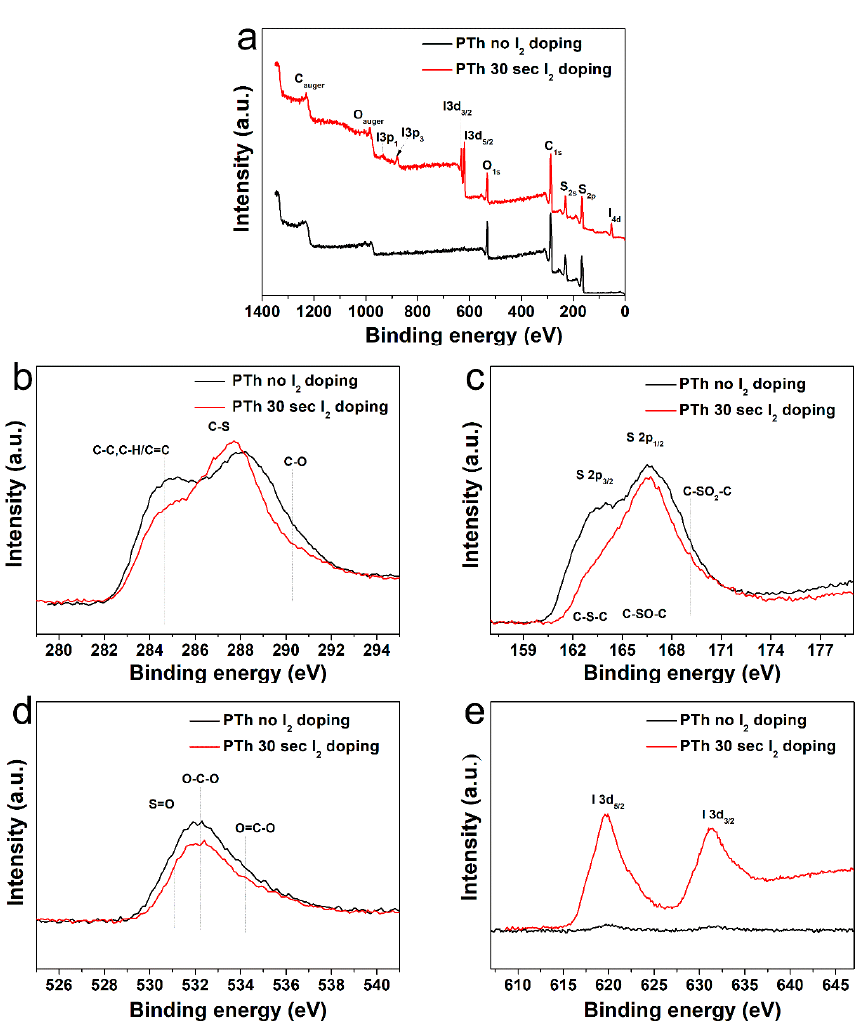
Figure 3. ( a ) XPS spectra of the plasma polymerized thiophene films without and with I 2 doping. High-resolution XPS spectra of ( b ) C 1s, ( c ) S 2p, ( d ) O 1s, and ( e ) I 3d. Table 1. Elemental concentration in atomic percentages of PTh films without and with I 2 doping Table 3. Peak assignment and envelope composition of various S 2p core level spectra of PTh films observed in XPS spectra in Figure 3a. observed in XPS in Figure 3c.